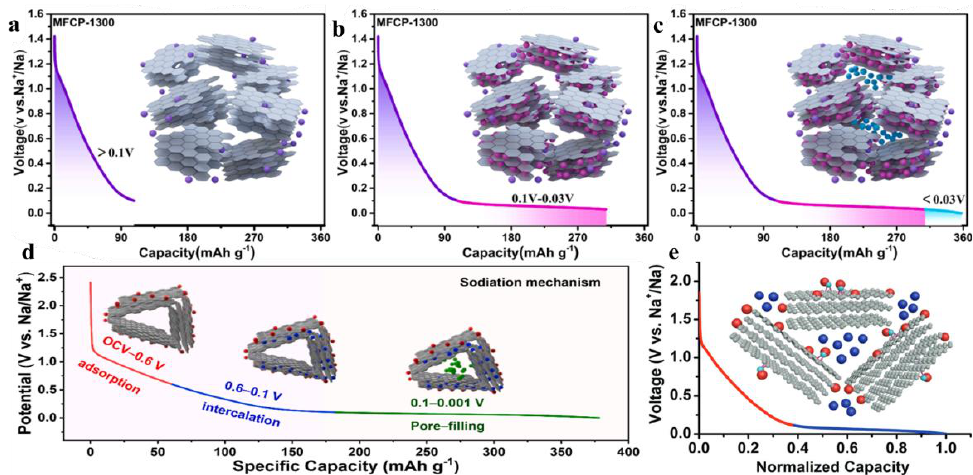
Figure 3. ( a – c ), schematic diagram of Na + storage mechanism of MFCP-1300 [93] ( d ), schematic dia- gram of Na + storage [94] (copyright Elsevier, 2022) ( e ), schematic diagram of adsorption-pore filling mechanism [95] (copyright Wiley, 2018).